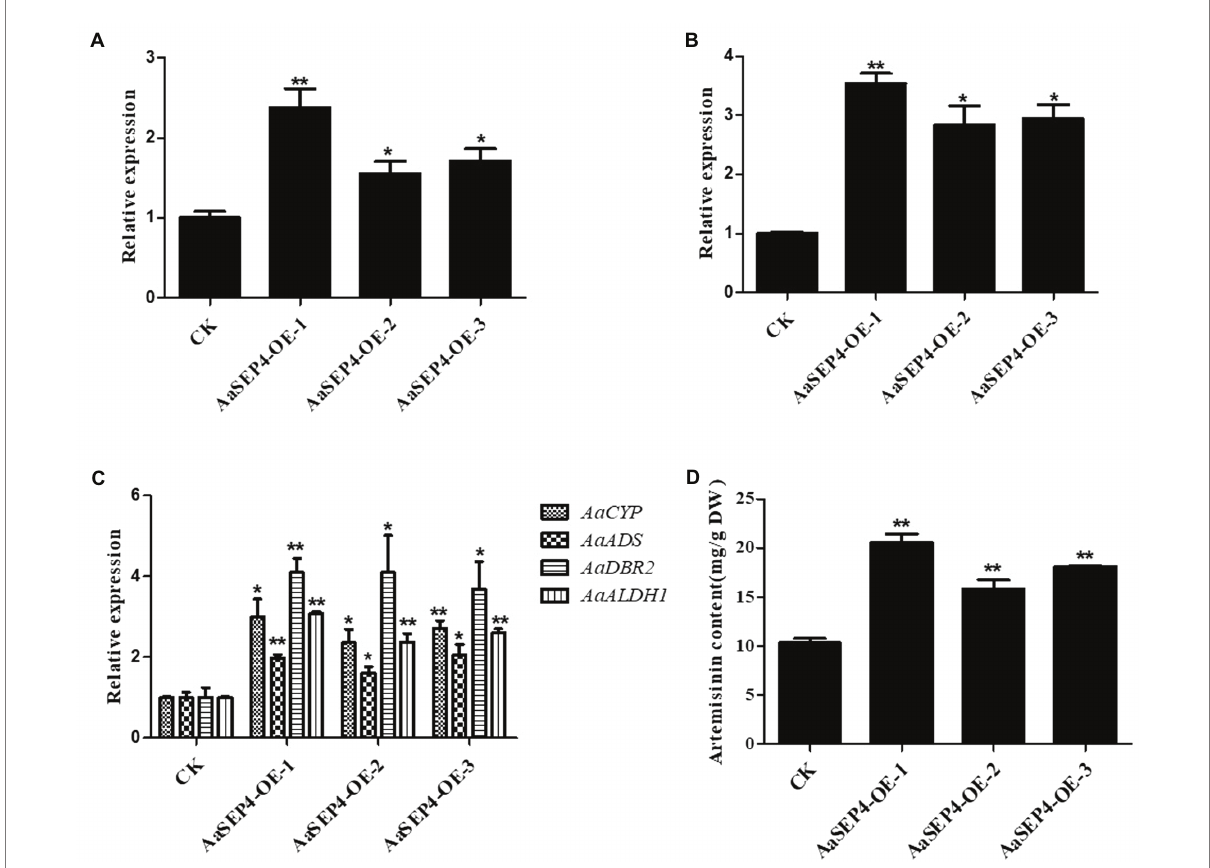
FIGURE 5 AaSEP4 is a positive regulator of artemisinin biosynthesis. Expression levels of AaSEP4 (A) , AaGSW1 (B) and four enzyme genes (C) in AaSEP4 overexpression transgenic plants. Actin was used as internal reference. (D) Artemisinin content in AaSEP4 overexpression lines measured by high- performance liquid chromatography (HPLC). All data are given as means ± SD ( n = 3) * p < 0.05; ** p < 0.01; Student’s t